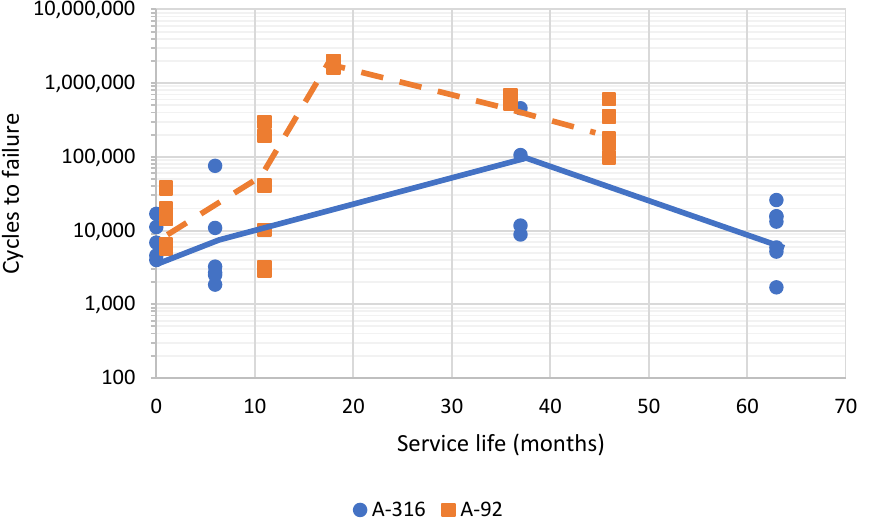
Figure 10. Evolution of the resistance to fatigue cracking of the highway section studied as a function of the service life.